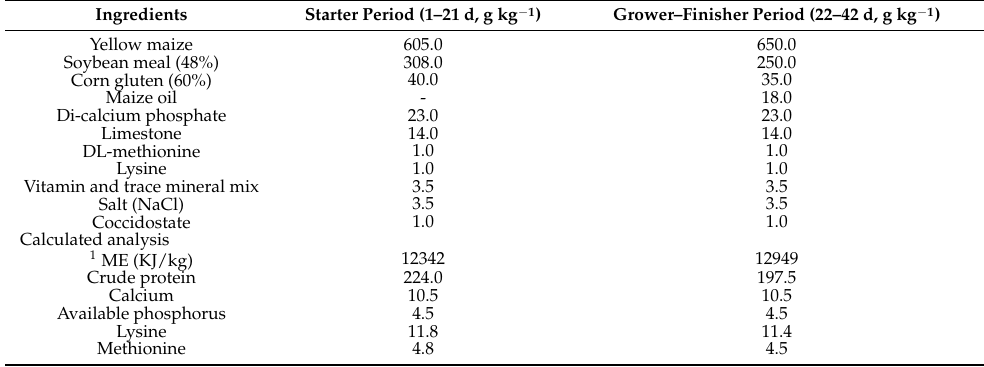
Table 1. Ingredient composition and calculated chemical analysis of the basal